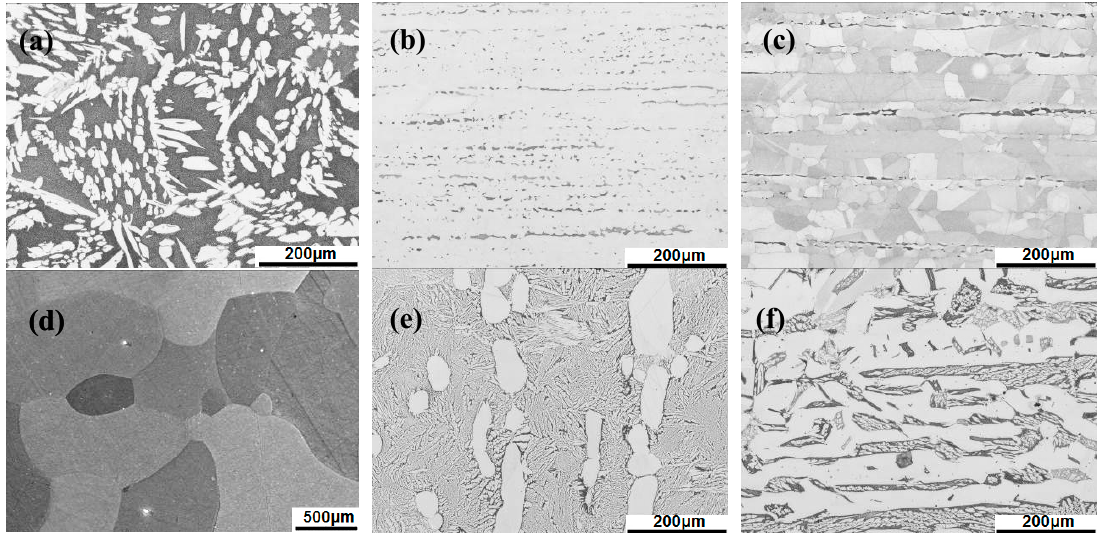
Figure 1. Indicative optical micrographs showing the phase structure of longitudinal sections of “as received”: ( a ) CW510L, ( b ) CW511L, ( c ) C27450 and “heat treated” conditions: ( d ) CW510L, ( e ) CW511L, ( f ) C27450 Pb-free brasses. Note that bright areas represent α -phase and dark areas represent β -phase regions.